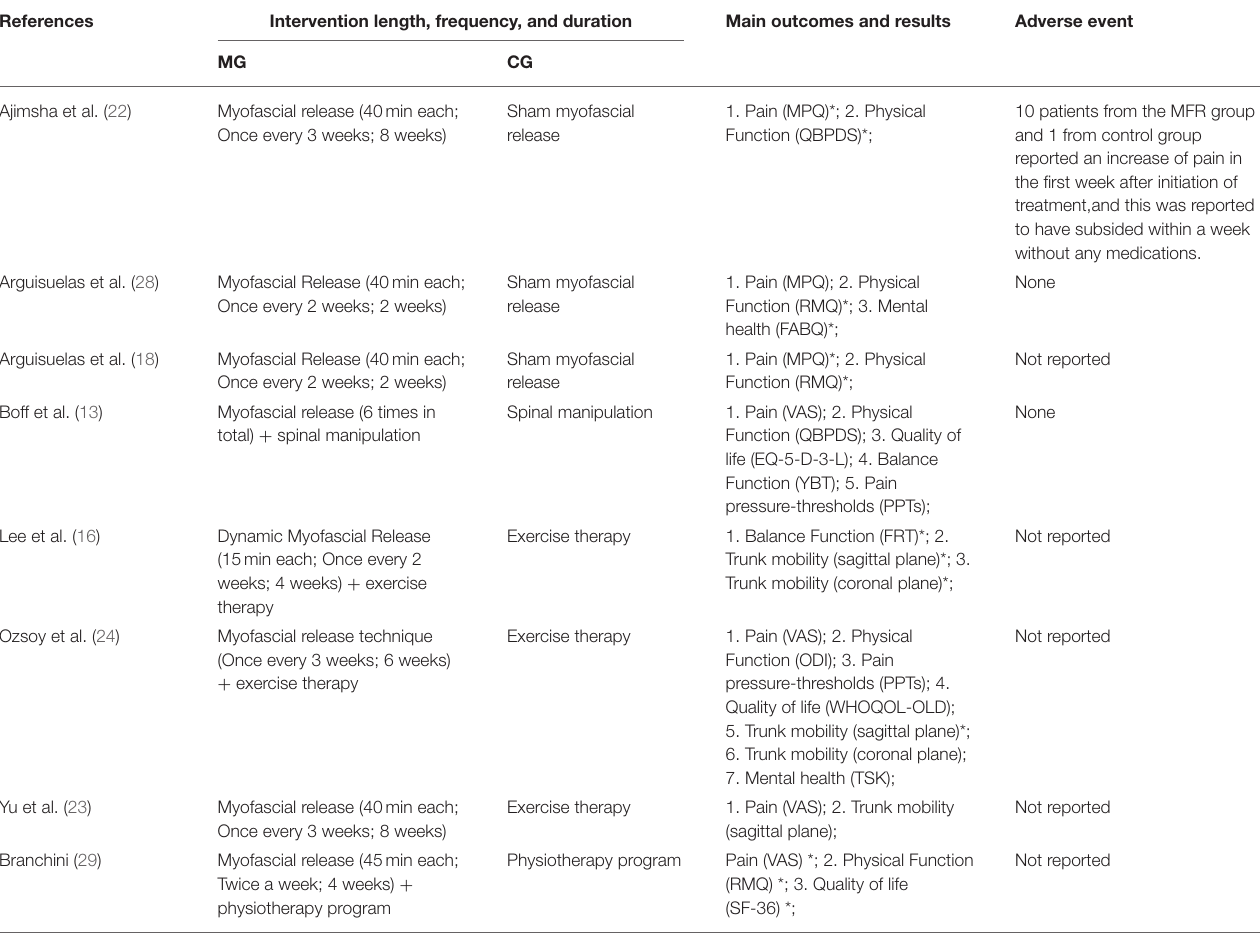
TABLE 2 | Intervention characteristics and outcome